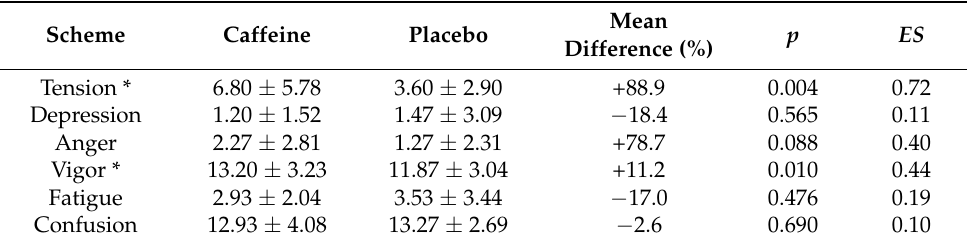
Figure 1. Mean subjective vitality scale (SVS) scores (thick line) and scores recorded in each partici- pant (dotted lines). PLAC: placebo group; CAFF: caffeine supplementation group. * Significant dif- ference between caffeine and placebo ( p < 0.05). Table 1. Scores obtained for the different profile of mood states (POMS) scales for the two experi- mental conditions (caffeine, placebo) .